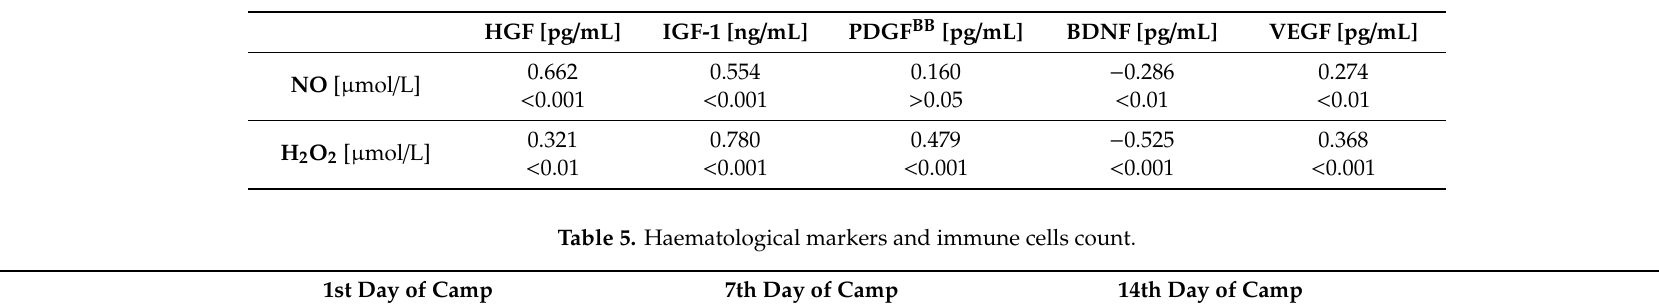
Table4. Relationships(Pearson’scorrelationcoe ffi cients)betweenoxi-inflammatorymediatorsNOandH 2 O 2 , andgrowthfactorsHGF,IGF-1, PDGF BB , BDNFandVEGF.